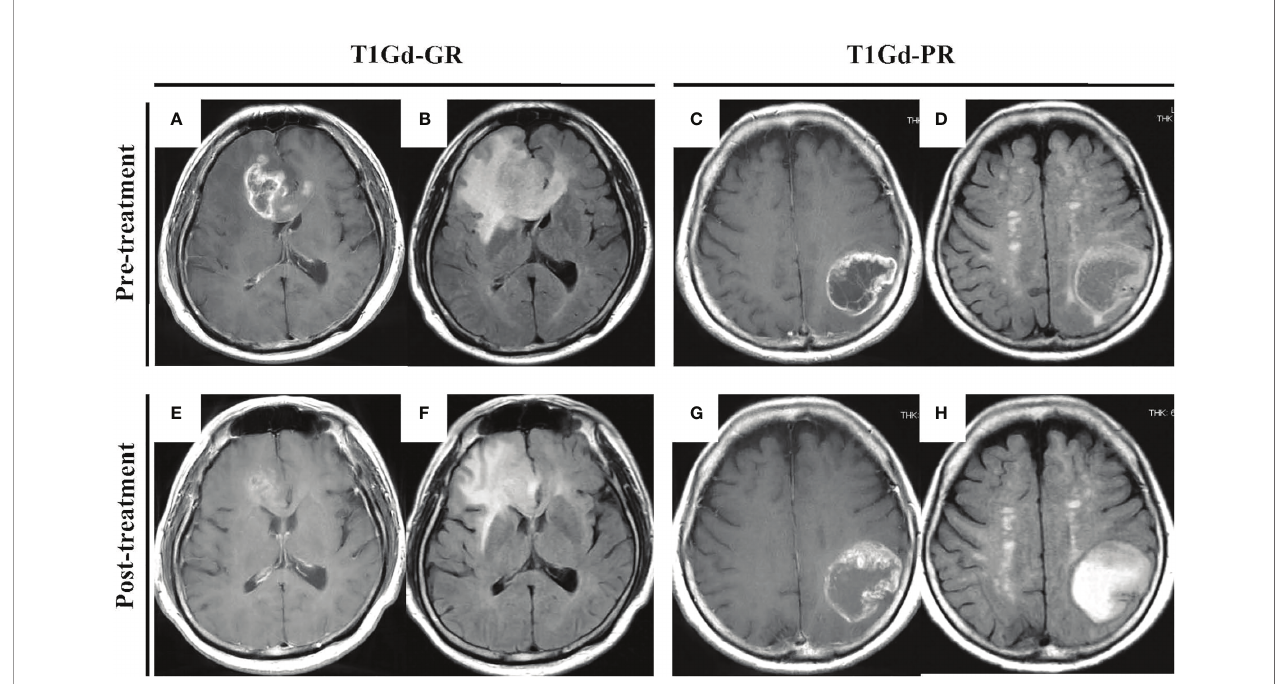
FIGURE 1 | “ Typical ” GBM demonstrating a huge enhanced tumor with perifocal edema before (A – D) and after (E – H) neoBev. Regression rates of T1Gd-GR (A, E) , T1Gd-PR (C, G) , FLAIR-GR (B, F) , and FLAIR-PR (D, H) after neoBev were − 61%, − 14%, − 71%, and − 26%, respectively. FLAIR, fl uid-attenuated inversion recovery; GBM, glioblastoma; GR, good rensponder; PR, poor responder; T1Gd, T1-weighted images with gadolinium